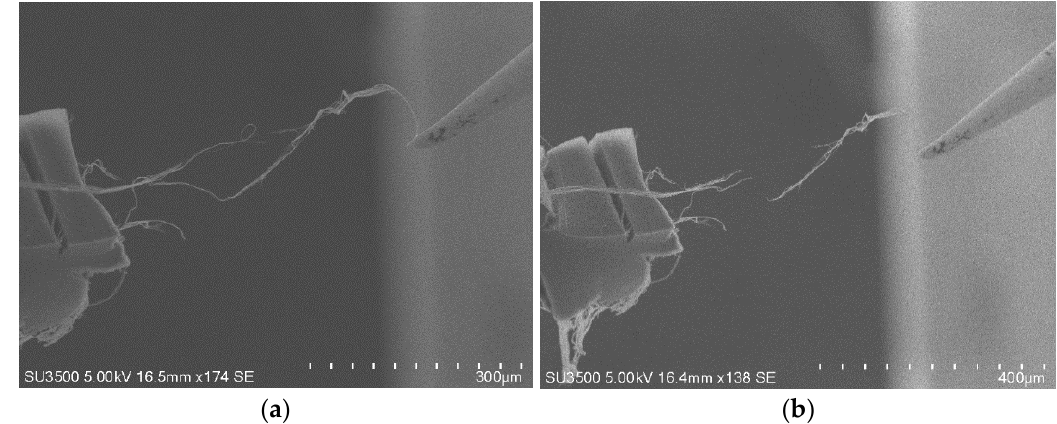
Figure 3. Breakdown of the bifurcated MWCNT bundle. ( a ) Breakdown of the upper part; ( b ) Breakdown of the lower part.